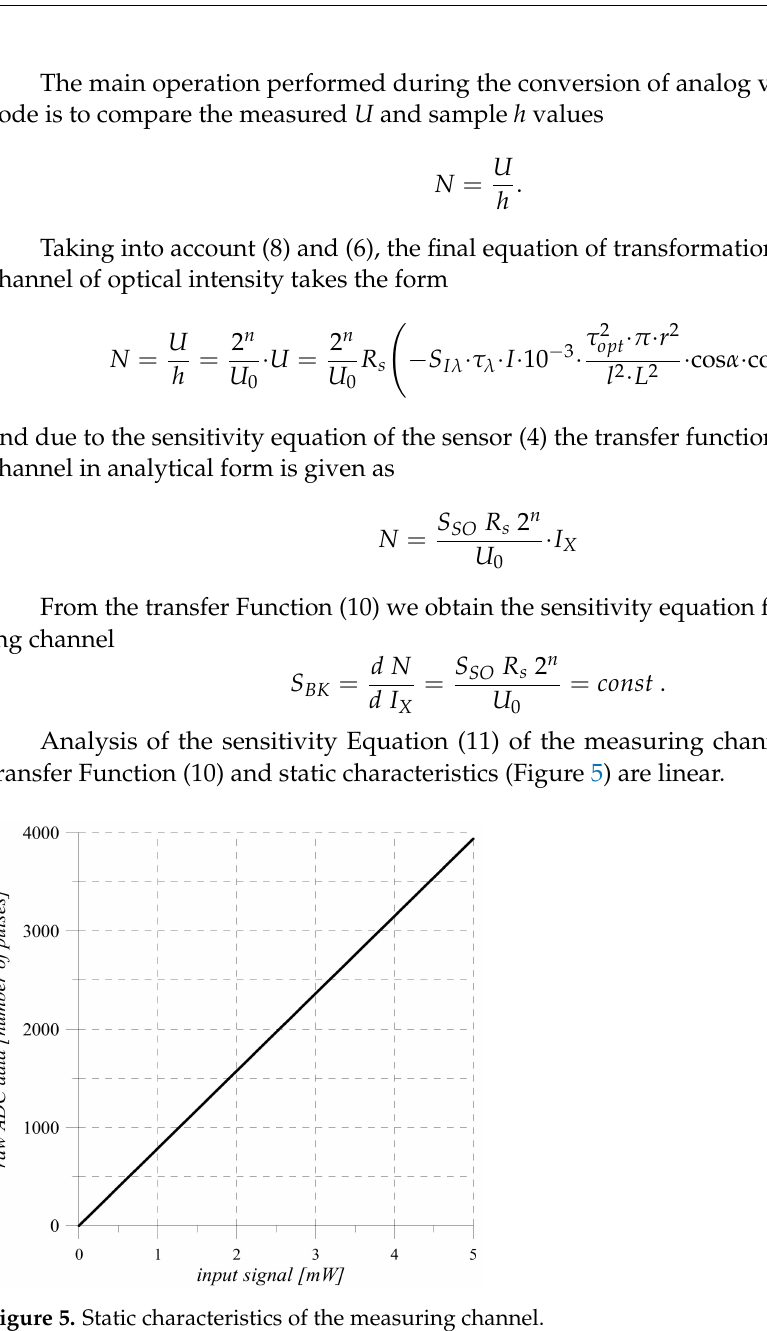
Figure 5. Static characteristics of the measuring